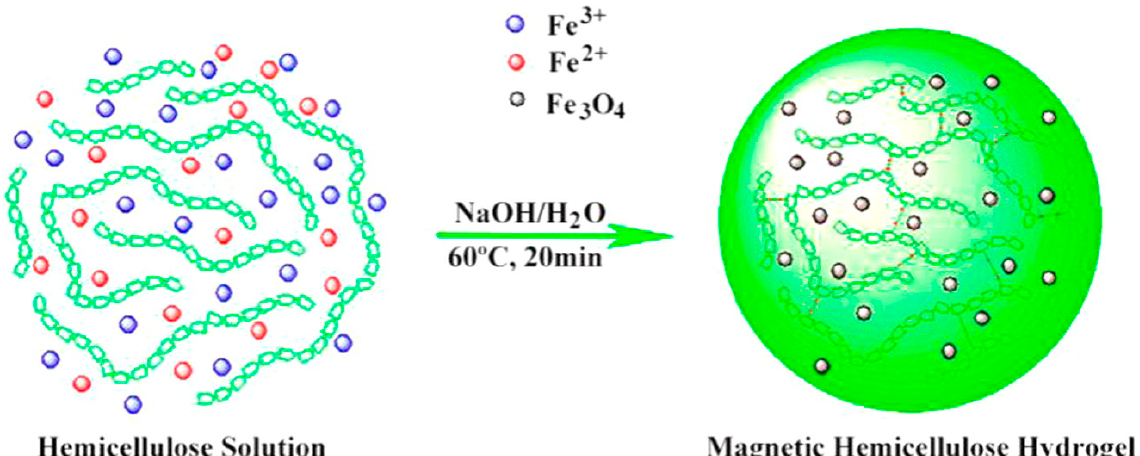
Figure 5. Synthesis of an in situ MNP-based magnetic hydrogel [111] © 2021 American Chemical Society.